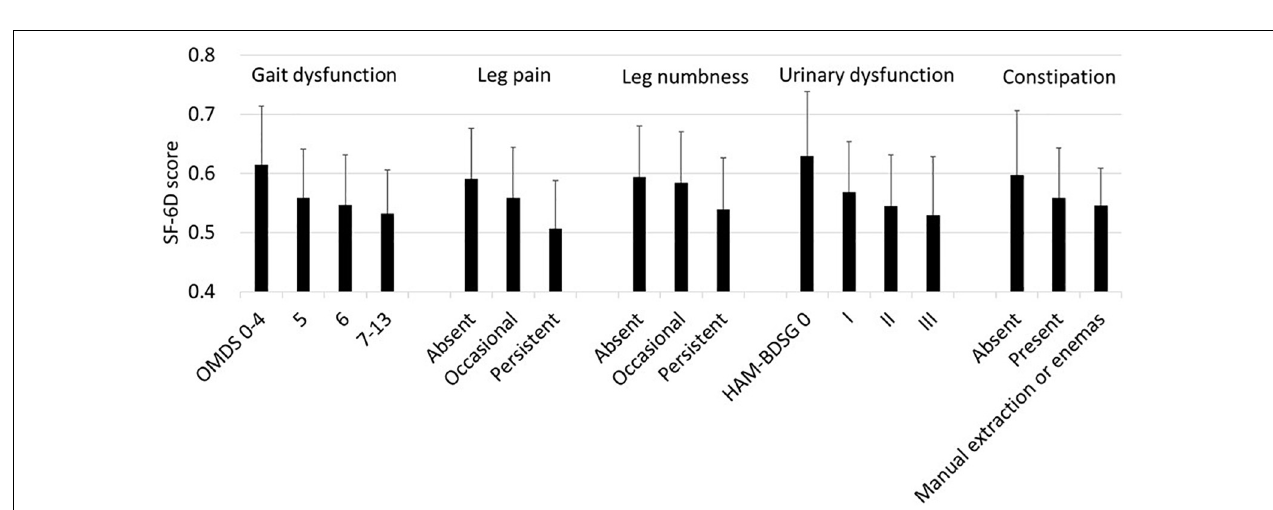
FIGURE 3 | SF-6D according to HAM-related symptoms. The SF-6D score is expressed as mean and standard deviation ( n = 538). HAM-BDSG, HAM-bladder dysfunction severity grade; OMDS, Osame Motor Disability